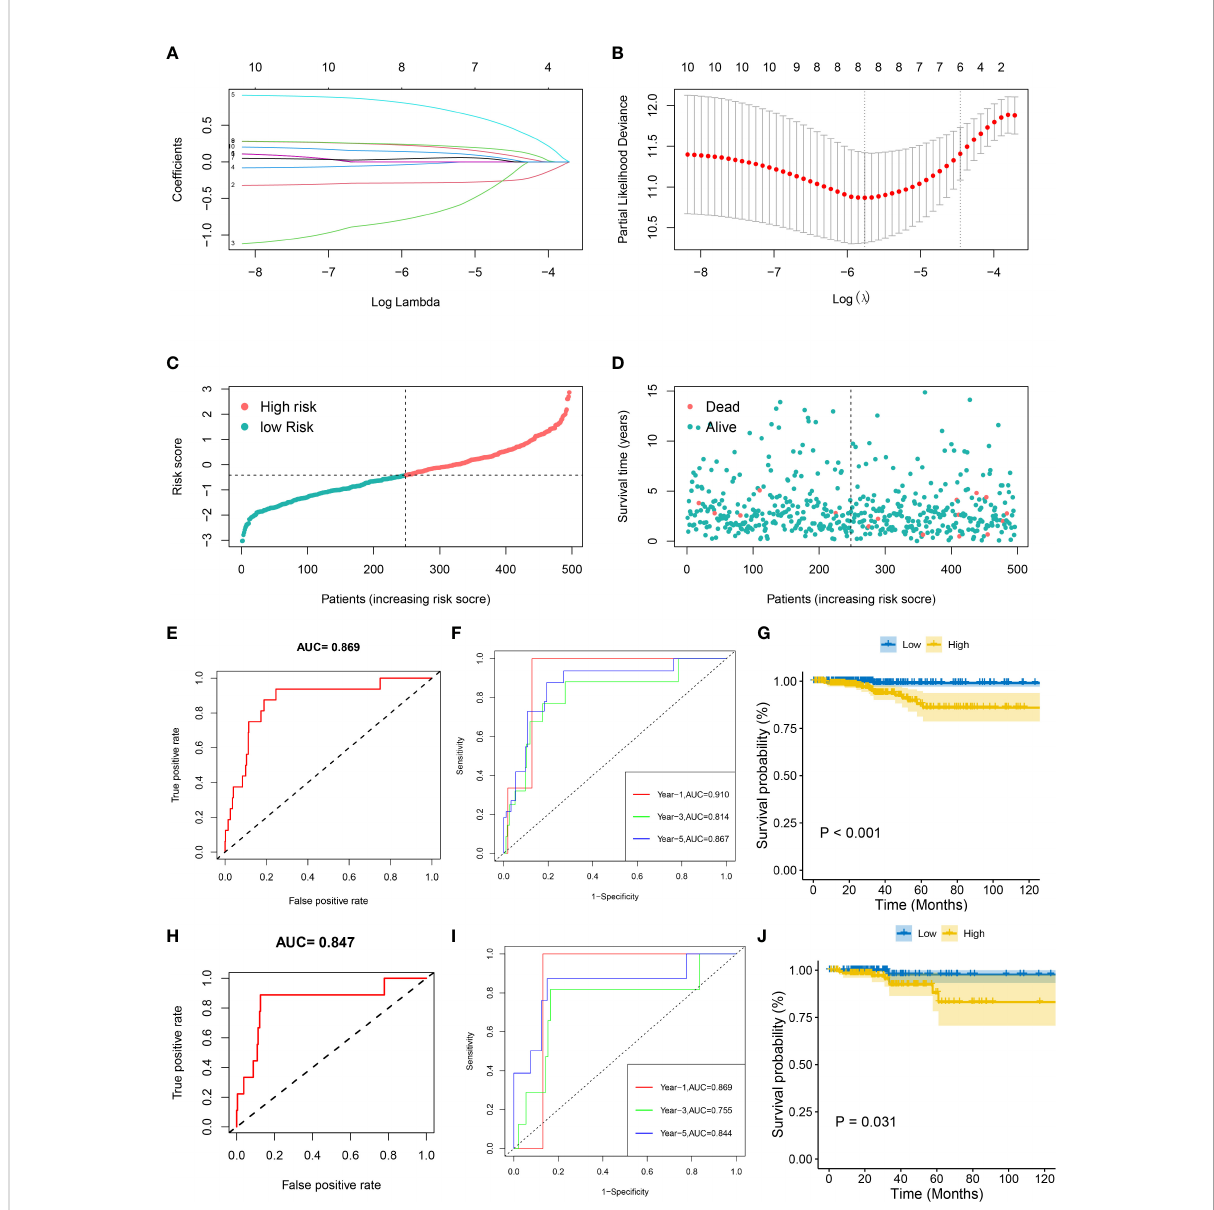
FIGURE 3 Prognostic analysis of the eight gene signature model in the TCGA cohort. (A) Tenfold cross-validation for tuning parameter selection in the LASSO model. (B) LASSO coef fi cient pro fi les of the eight prognostic genes for THCA. (C, D) The distribution and median value of the risk scores in the TCGA cohort. (E, F) The AUC ROC curves veri fi ed the prognostic performance of the risk score in the TCGA training cohort. (H, I) The AUCs of ROC curves veri fi ed the prognostic performance of the risk score in the TCGA testing cohort. (G, J) Kaplan-Meier curves for the OS of patients in the high-risk group and low-risk group in both the TCGA training and testing